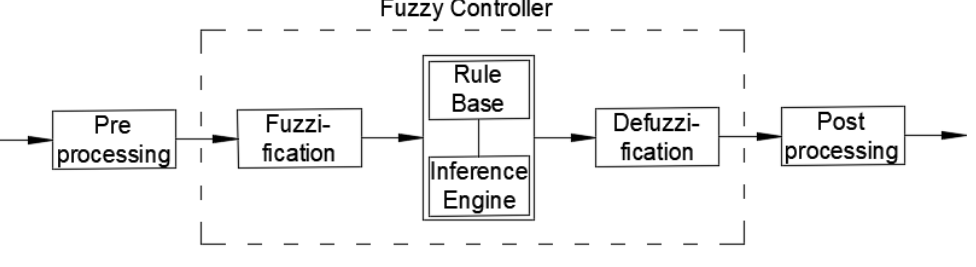
Figure 20. Structure of Fuzzy Logic controller.